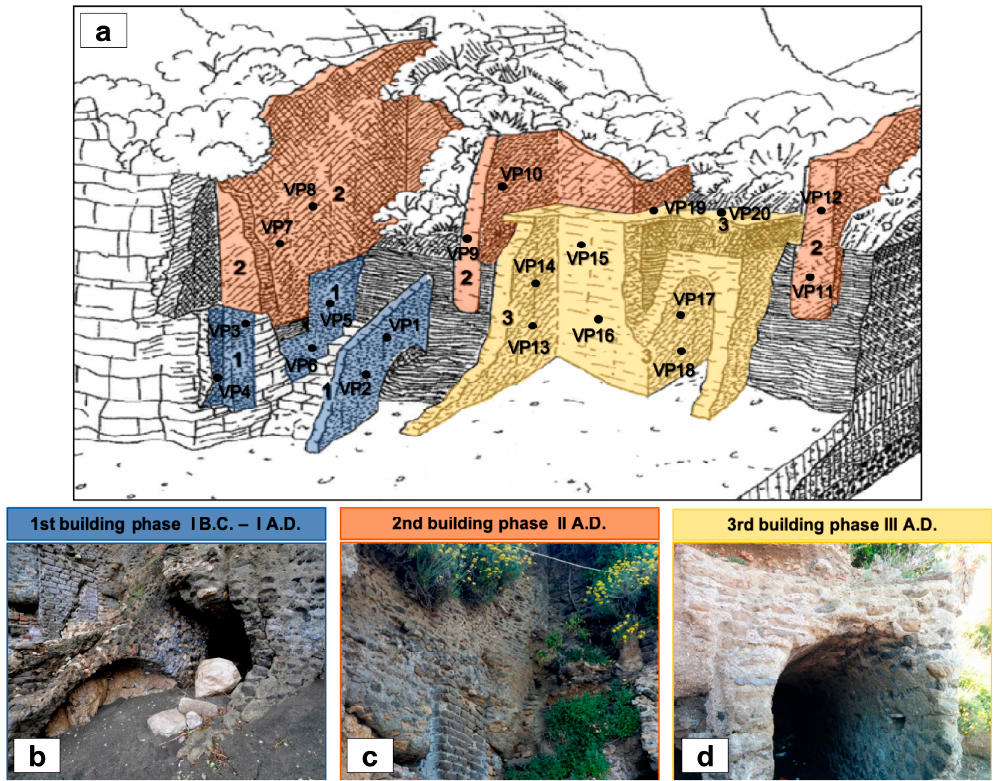
Figure 3. ( a ) Sketch of the Villa del Pezzolo archaeological remains on the beach (modified after [18]) with sampling points; ( b ) 1st building phase; ( c ) 2nd building phase; ( d ) 3rd building phase.